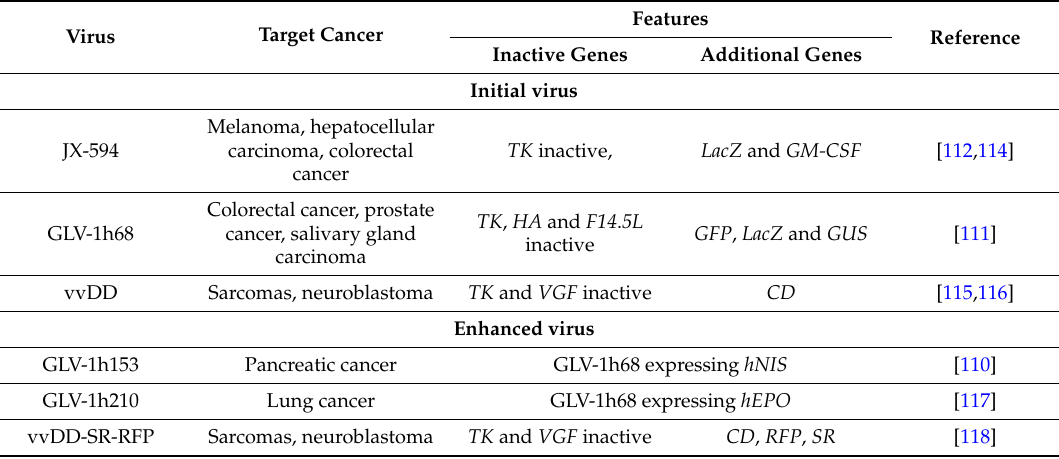
Table 3. Oncolytic vaccinia virus (VACV) developed for cancer